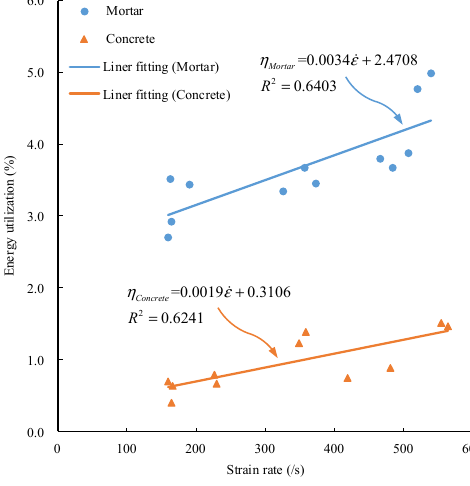
Figure 10. Relation between energy utilization and strain rate.